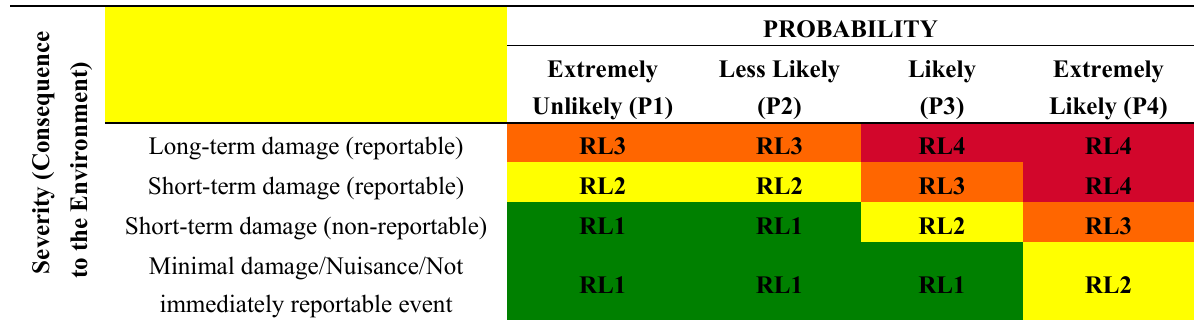
Table 2. Environmental risk matrix.